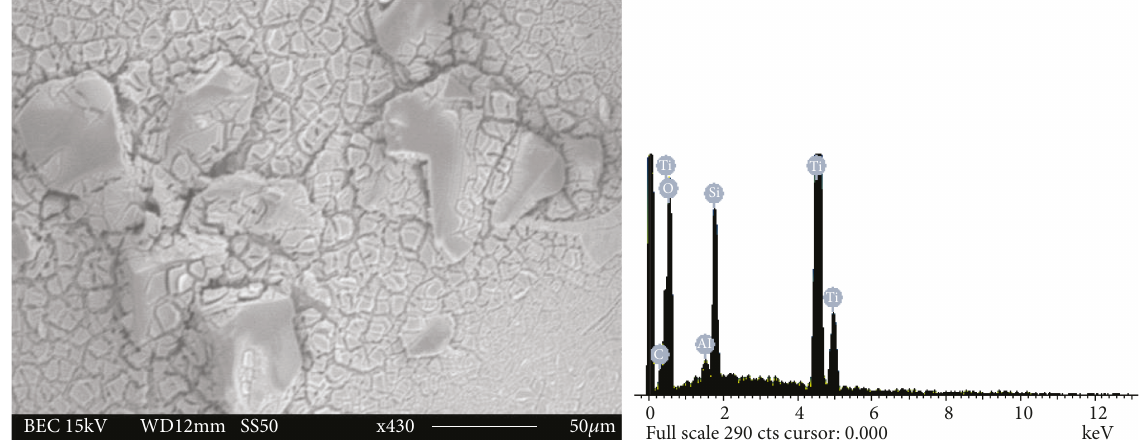
Figure 7: SEM image after 3 treatment cycles using stirring plate and 3 hours of